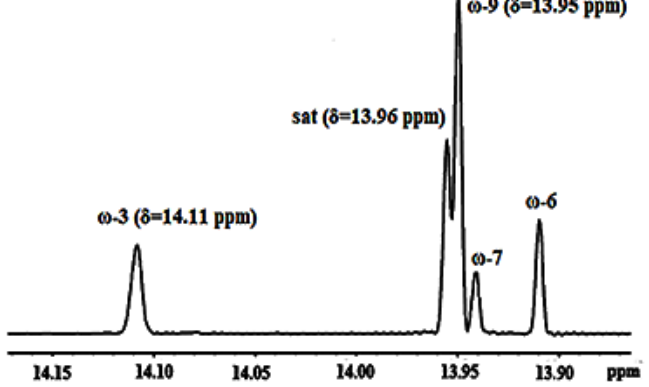
Figure 10. 13 C-NMR chemical shifts of the terminal methyl groups allow the identification and quantification of ω-3, ω-6, ω-7, ω-9 and saturated fatty acids of a salmon oil. Free download from: